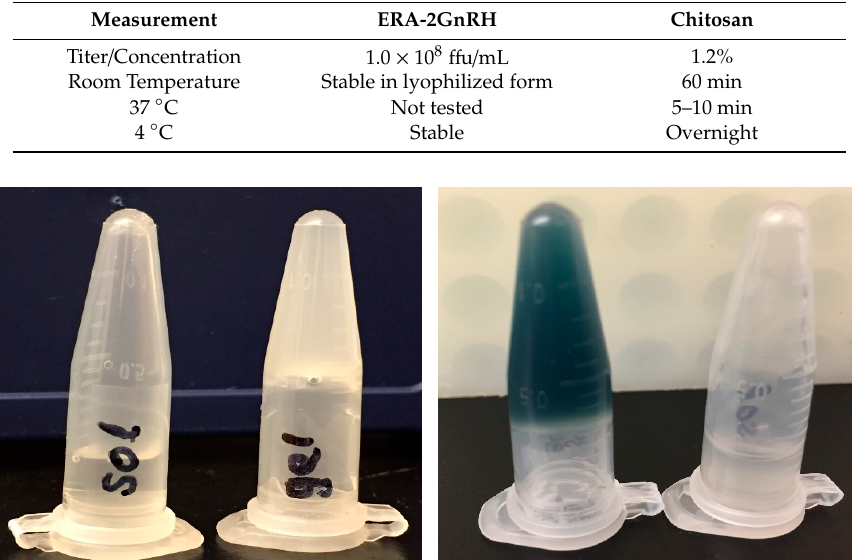
Table 1. Thermo-responsive hydrogel vaccine ERA-2GnRH.